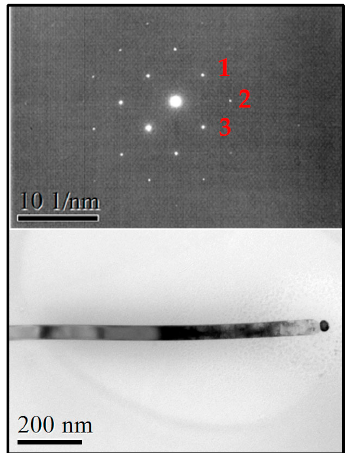
Figure 3. Gallium Oxide nanowire ( down ) and its selected area electron diffraction with spots labeled as 1, 2 and 3 corresponding to ((cid:2778)(cid:3365)(cid:2778)(cid:3365)(cid:2779)) , ((cid:2779)(cid:3365)(cid:2777)(cid:2781)) and ((cid:2778)(cid:3365)(cid:2778)(cid:2779)) respectively ( up